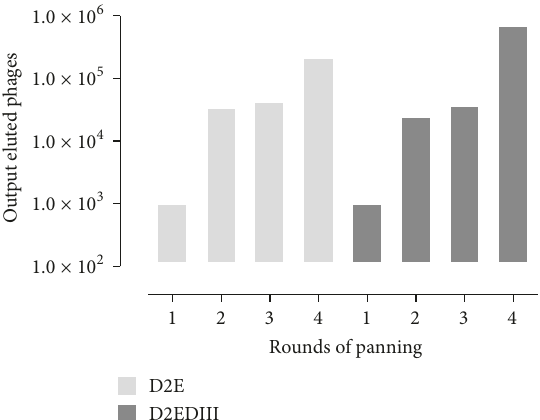
Figure 2: Eluted phages were enriched in successive rounds or panning. During each panning, 10 11 input phages were incubated with the target proteins (full DENV2 envelope or domain III) and eluted as described in Materials and Methods. The eluted phages were neutralized and titer was estimated. Data is presented as the absolute number of eluted phages at each step.